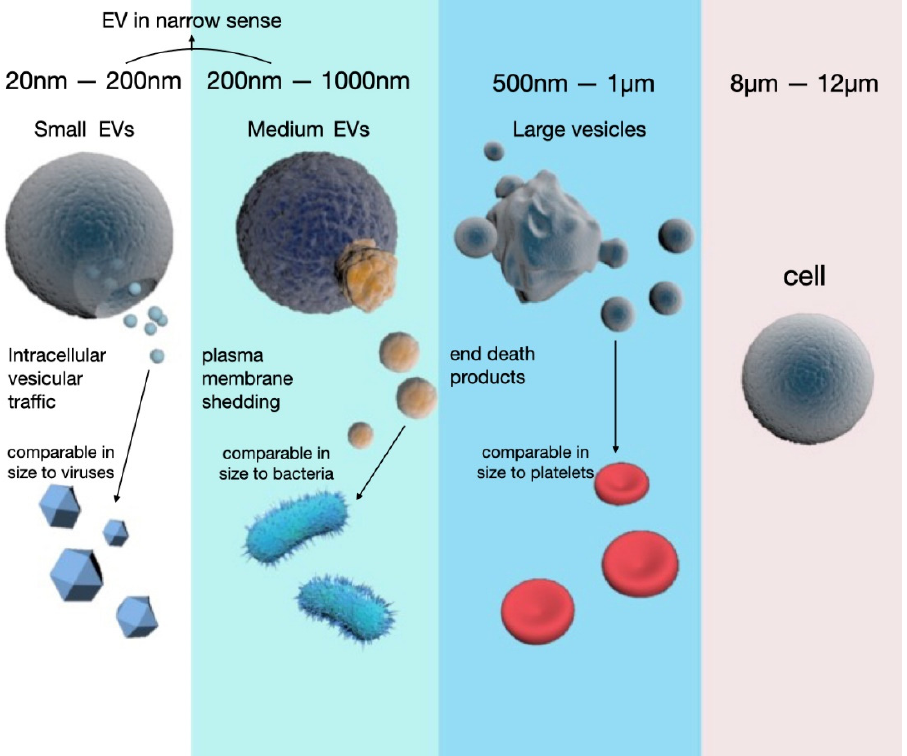
Figure 1. Schematic diagram of extracellular vesicle size and biogenesis. Extracellular vesicles (EVs) refer to a group of heterogeneous vesicles ranging from 20 nm to 5 µ m. Small vesicles ranging from 20 to 200 nm used to be named exosomes, while small to medium-size vesicles ranging from 200 to 500 nm used to be called microvesicles (MVs). The largest EVs, which used to be called apoptotic bodies (ABs), are often generated from dying cells. The biogenesis of these EVs has distinct pathways. As illustrated here, small EVs are often generated via a long journey including endosomes, ER / Golgi, and multivesicular bodies (MVBs). On the other hand, the other larger EVs can be produced via direct budding from the plasma membrane. It is commonly facilitated by lipid raft proteins as discussed in this review. The largest-size EVs, or previously referred to as ABs, are broken down from apoptotic cells.